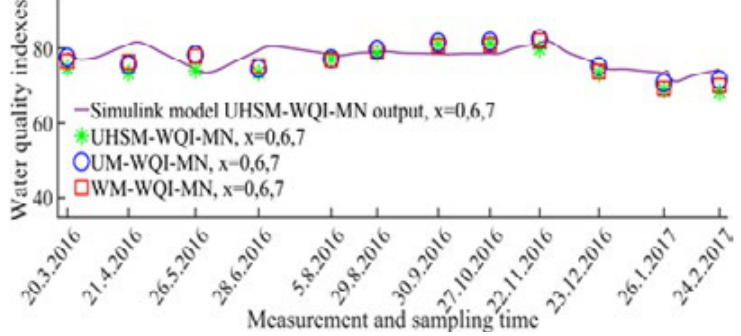
Fig. 10: Water quality index output from model with three input variables for station FM